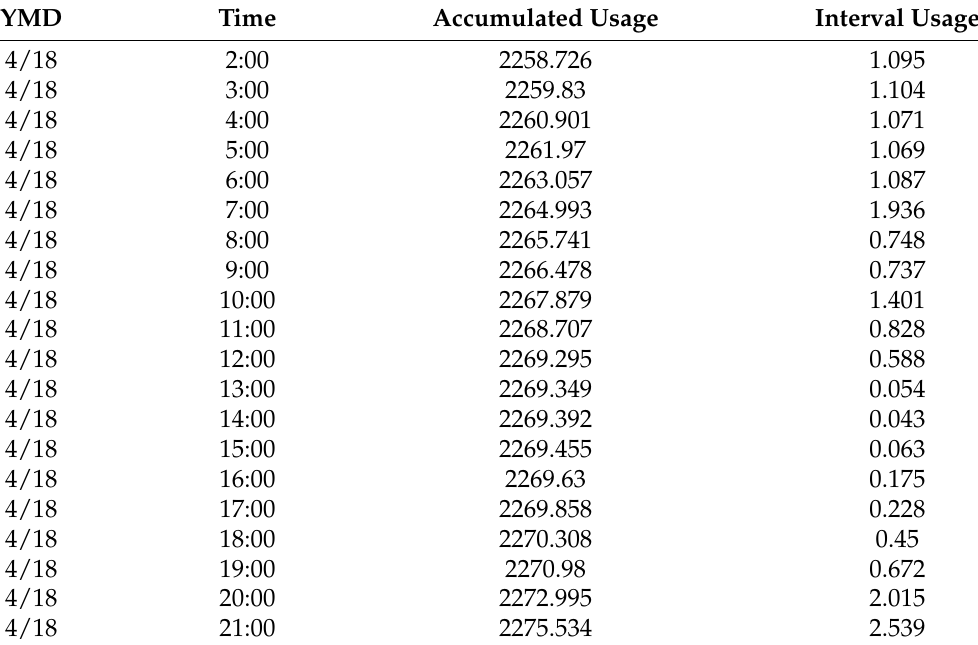
Table 4. Reference data at the same time band of similar past situations.